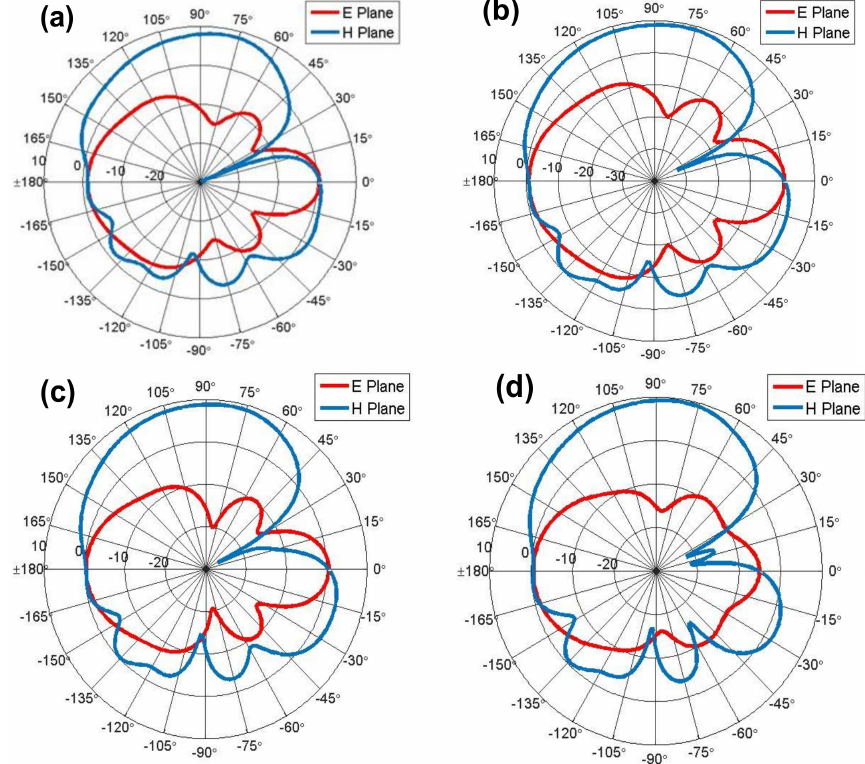
Figure 11. Two-dimensional gain plots of the design antennas ( a ) Type-A antenna ( b ) Type-B antenna ( c ) Type-C antenna ( d ) Type-D